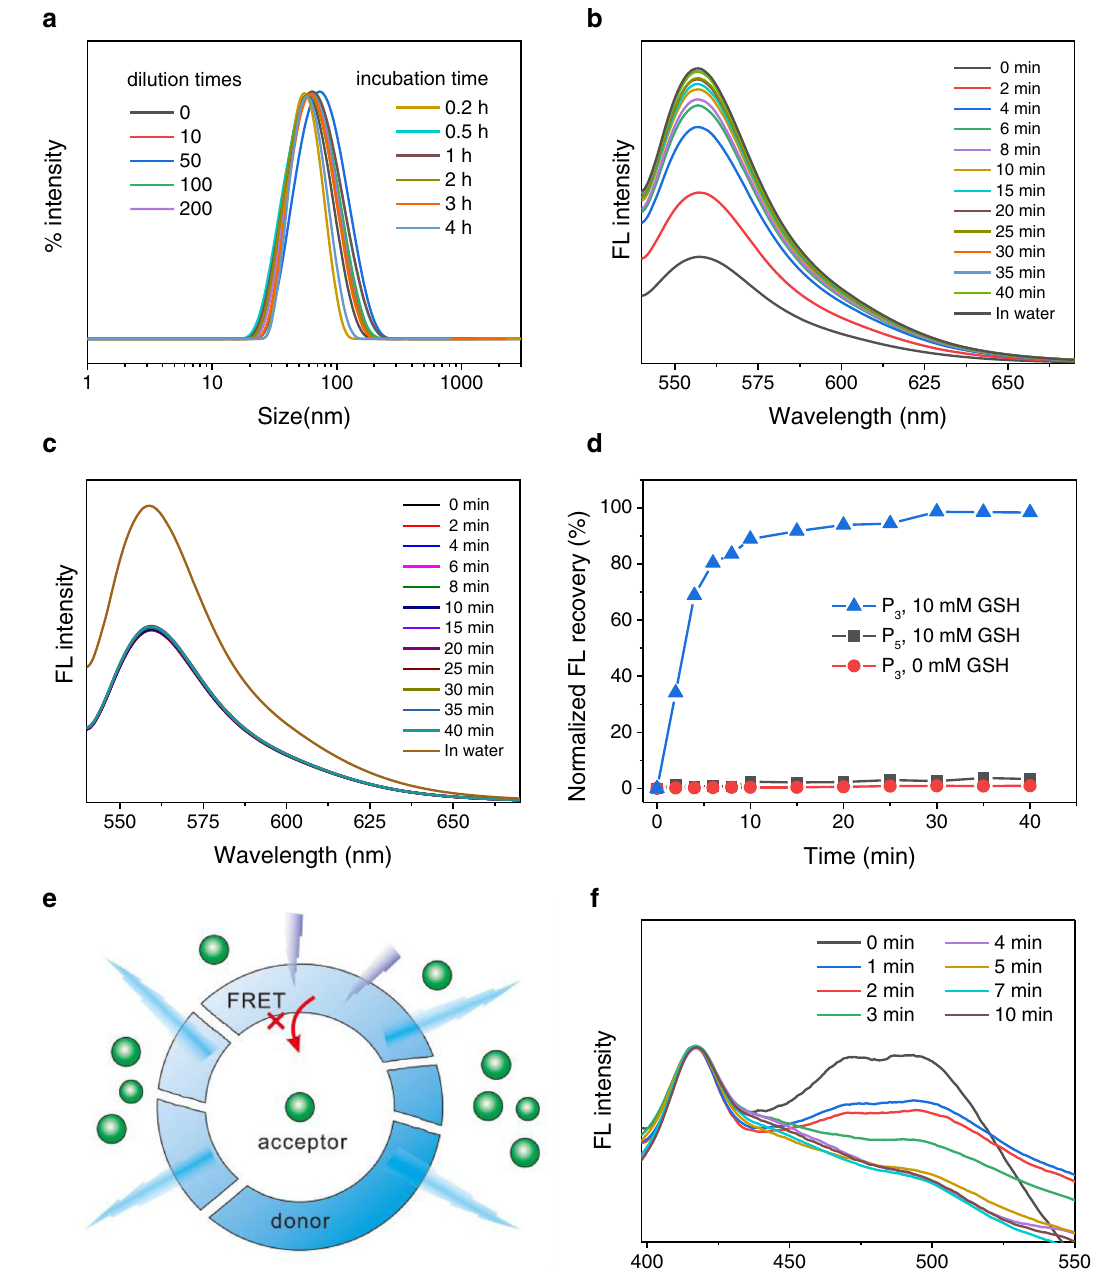
Fig. 4 | Ultrahigh stability and superfast responsivity. a Size distribution of P 3 assemblies diluted with water for different times and those incubated with SDS (0.02M) for different times. b , c Fluorescence spectra ( λ ex =526nm) of R6G- loaded P 3 ( b ) and P 5 assemblies ( c ) incubated with 10mM of GSH for different times. d Releasepro fi lesofR6GfromPUassembliesinthemediawithorwithout